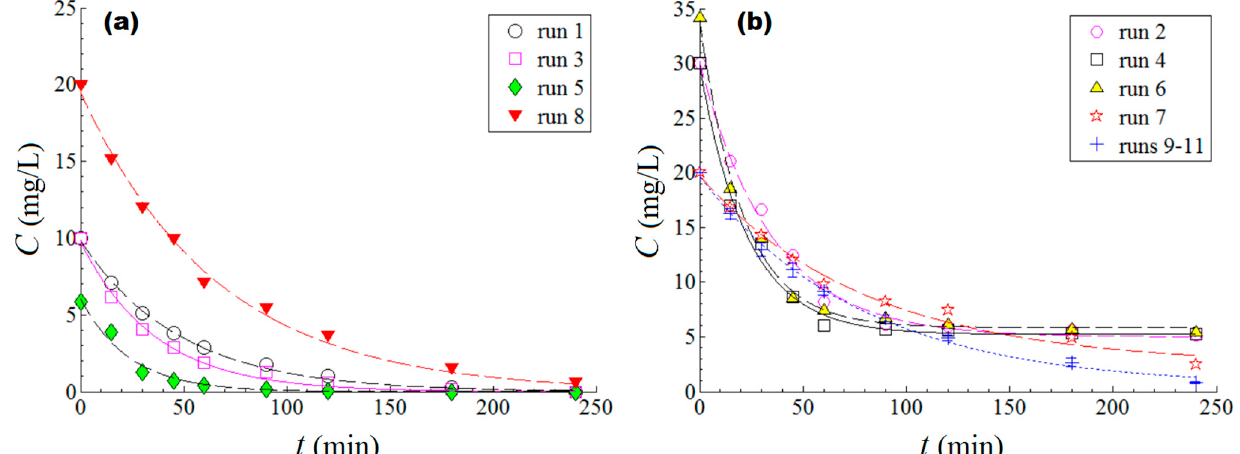
Figure 8. Kinetics of ciprofloxacin photodegradation in aqueous solutions measured for each run (experimental condition) performed under visible light irradiation and in the presence of the produced catalyst (ZnO:Nd (0.1%)): ( a ) experimental data fitted to pseudo-first-order (PFO) kinetic model; ( b ) experimental data fitted to pseudo-first-order with stable component (PFO-SC) kinetic model. Table 4. Analysis of variance (ANOVA) for the fitted model ˆ Y ( x 1 , x 2 )